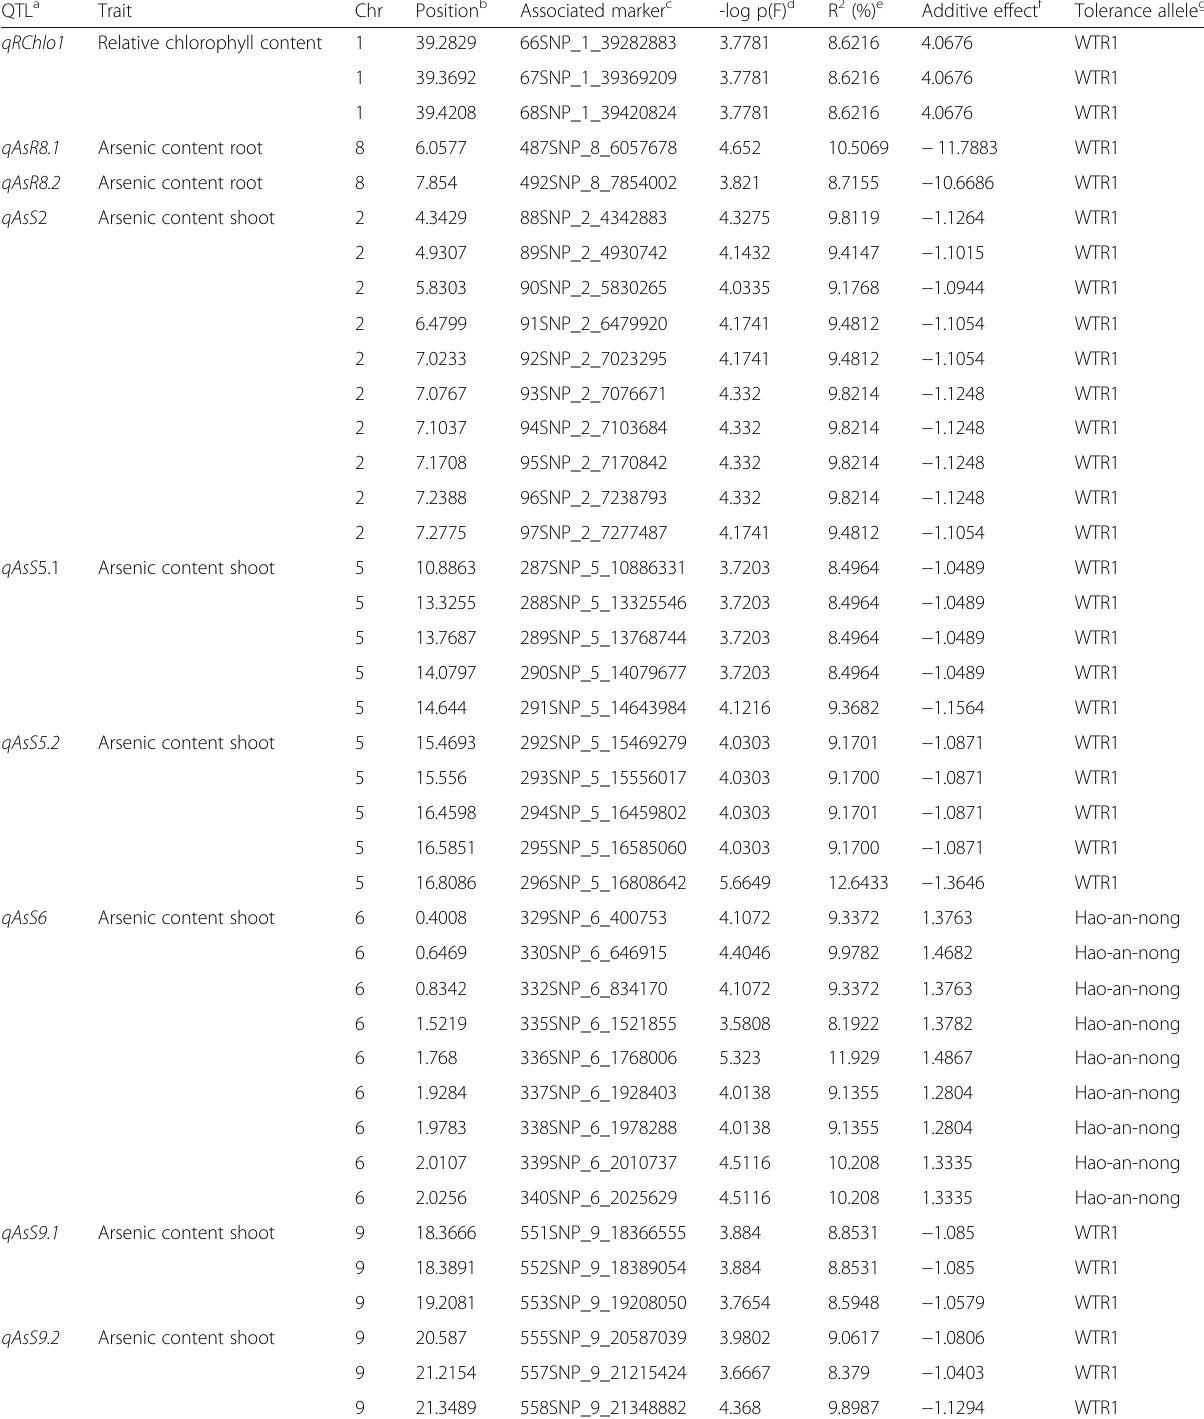
Table 2 QTLs associated with As-related traits after 18 days of 10 ppm As stress in WTR1× Hao-an-nong population by single marker